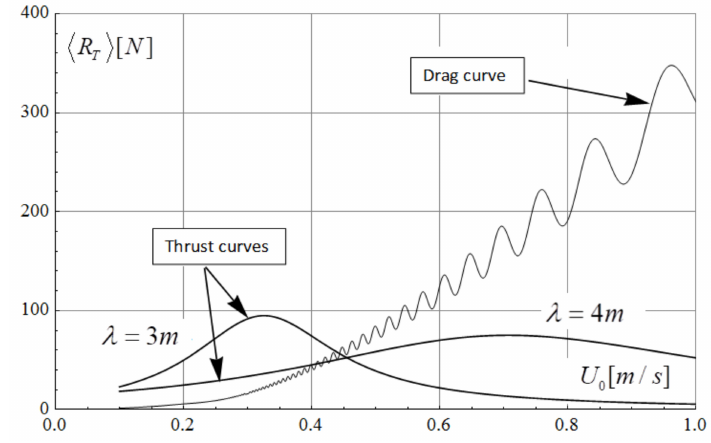
Figure 12. Calculation of the thrust and speed of WG (short waves). The calculated data on thrust, speed of motion and ideal efficiency of the WG under study are summed up in Table 1. Table 1. Wavelength, Speed, Thrust, Ideal